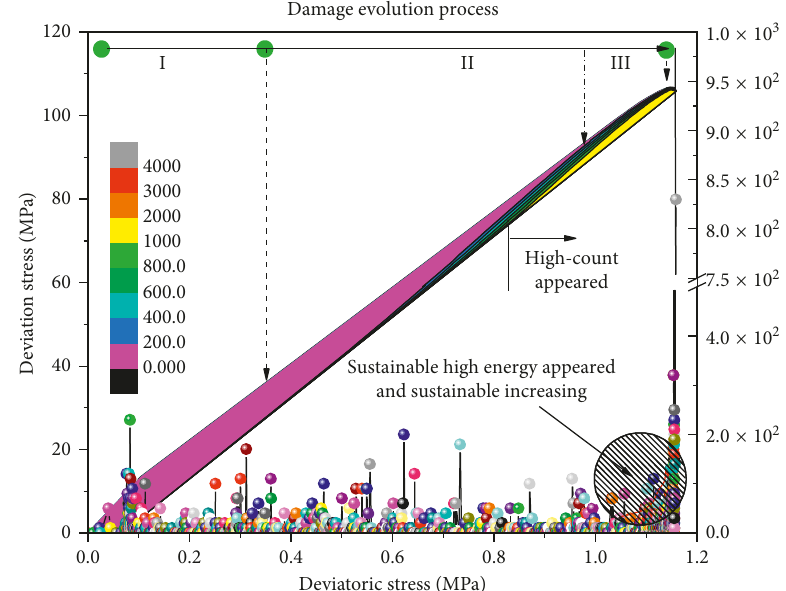
Figure 11: Partial stress-strain acoustic emission counting: acoustic emission energy damage evolution process by sz-21.